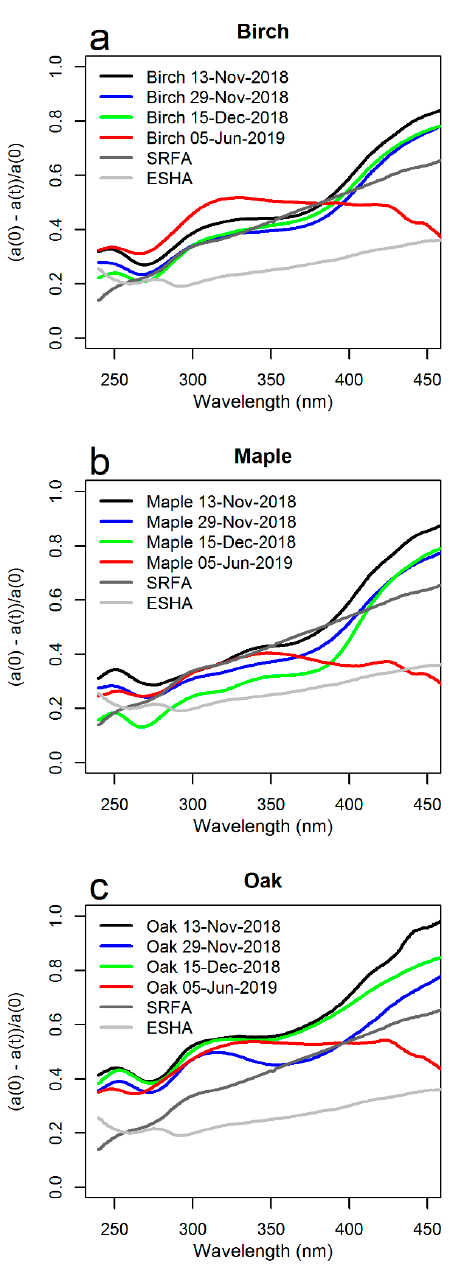
Figure 1. Change in absorption following borohydride treatment for ( a ) birch leachates, ( b ) maple leachates, and ( c ) oak leachates. All leaf litter leachates, excluding maple 15 December 2018 displayed higher loss of UV absorption following treatment. Additionally, the litter from June 2019 all displayed decreased response to borohydride from 400–500 nm in relation to the autumn leachates and reference standards.